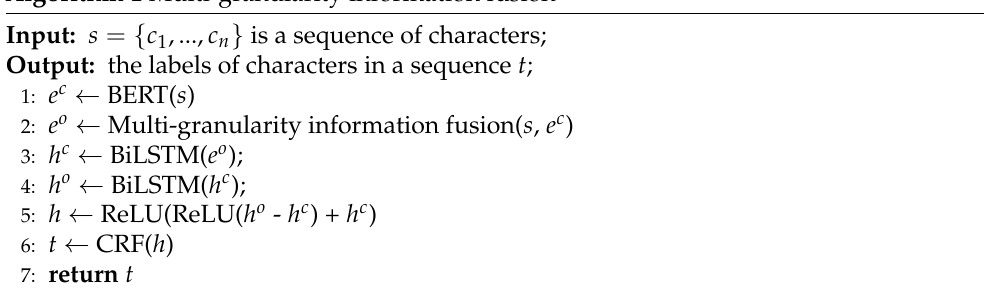
Algorithm 1 Multi-granularity information fusion